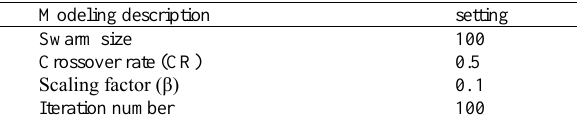
Table 2. Differential Evolution (DE) parameters setup. Modeling description setting Number of genomes Table 3. Differential Evolution (DE) parameters setup.